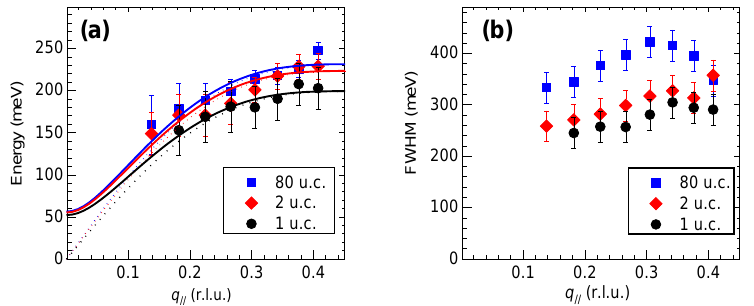
Figure 5. ( a ) Dispersion and ( b ) FWHM of magnetic excitations in 1 (black circles), 2 (red diamonds) and 80 (blue squares) u.c.-thick NdBa 2 Cu 3 O 7 − x films. Continuous (dotted) lines show the corresponding optical (acoustic) magnetic branch used to fit the